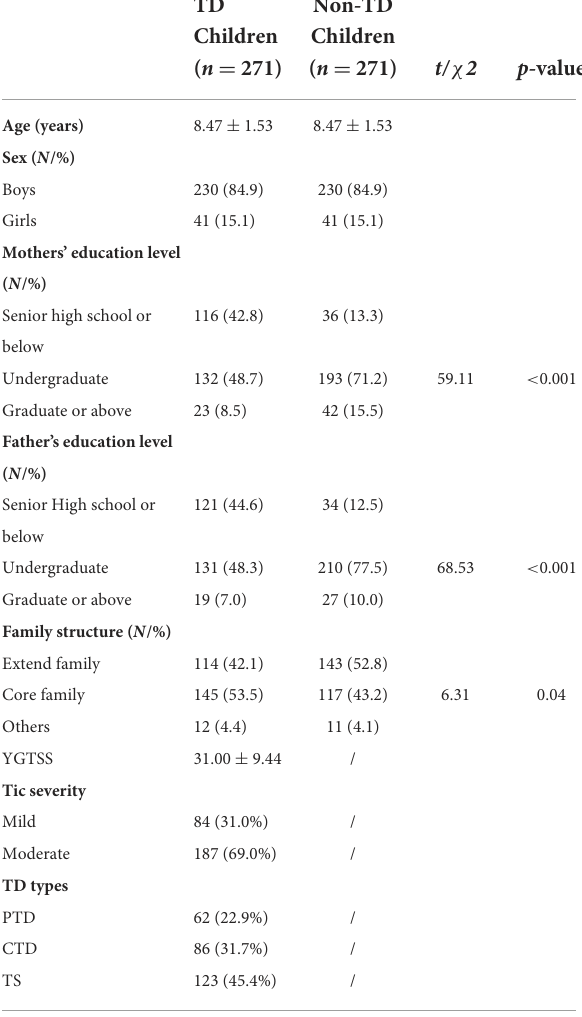
TABLE 1 Descriptive characteristics of children with and without